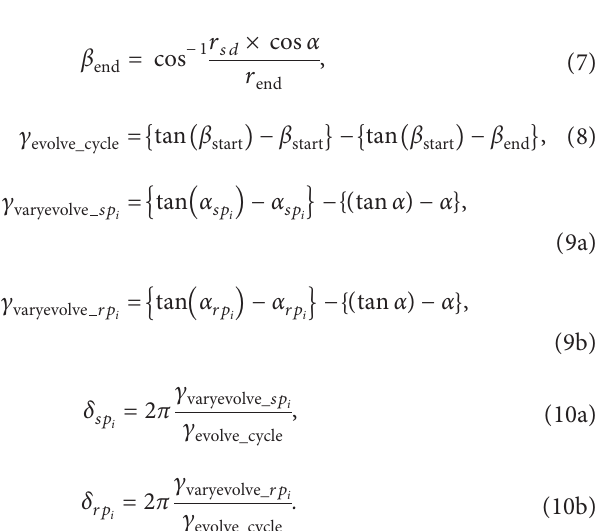
Figure 3: Flow chart of the